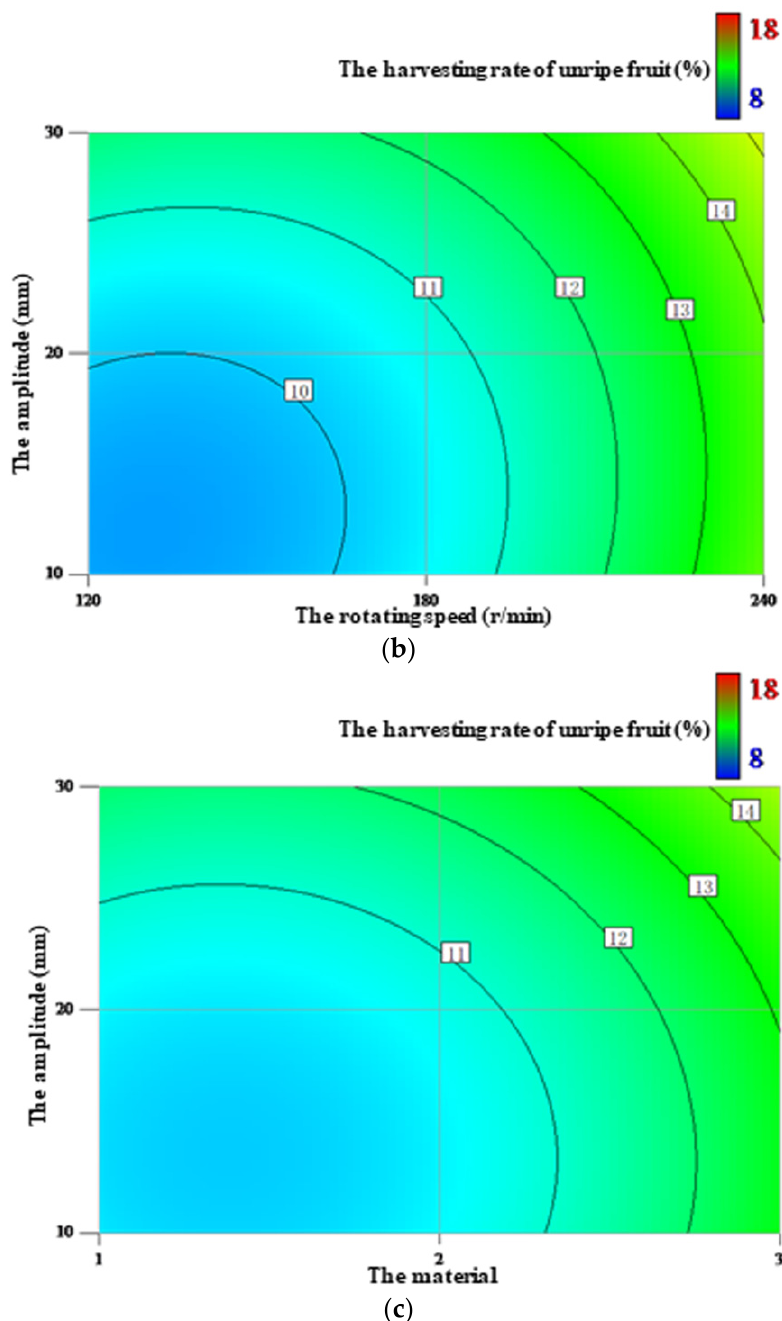
Figure 5. The response surfaces of the harvesting rate of unripe fruit affected by the rotating speed and material ( a ), the rotating speed and amplitude ( b ), and the material and amplitude ( c ). The response surfaces of the damage rate of ripe fruit affected by the factors are shown in Figure 6. As shown in Table 7, the material had the largest influence on the damage rate of ripe fruit, followed by the amplitude and rotating speed, in that order. The interactions between each combination of the factors did not significantly influence the damage rate of ripe fruit. As shown in Figure 6a, as the rotating speed increased, the damage rate of ripe fruit initially remained unchanged, but then increased rapidly. Figure 6b shows that, as the amplitude increased, the damage rate of ripe fruit decreased slowly at first, but then increased rapidly. Finally, as shown in Figure 6c, the damage rate of ripe fruit was highest when the polypropylene was used, followed by the silica gel and